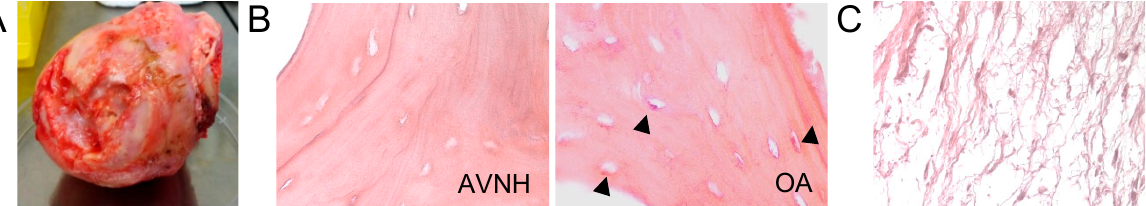
Figure 1. ( A ) Gross specimen of advanced femoral head osteonecrosis with associated osteoarthritis, showing complete loss of articular surface and collapse of the central region of the head. ( B ) Hema- toxylin and eosin-stained sections showing trabeculae; ( A ) partially necrotic trabecula: bone showing empty lacunae in ONFH samples. (20 × ). ( B ) Osteoarthritis (control group) trabecula showing lacunae containing viable osteocytes, necrotic osteocytes, and empty lacunae (20 × ). ( C ) Hematoxylin and eosin-stained section showing dense medullary fibrosis in ONFH bone samples (20 ×